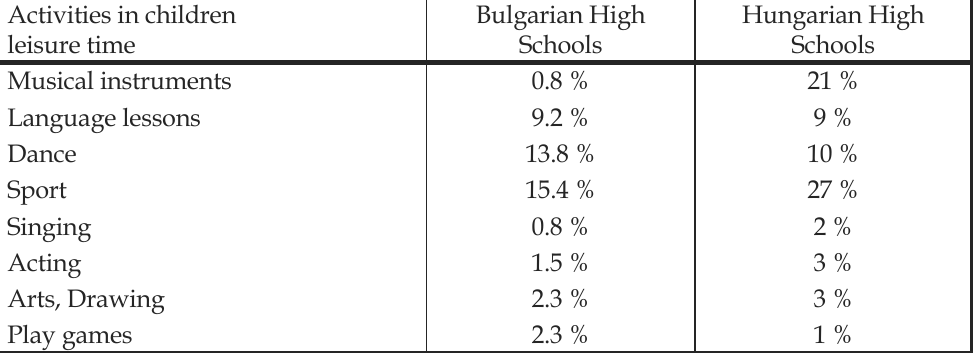
Table 3. Activities in children leisure time in Hungary and